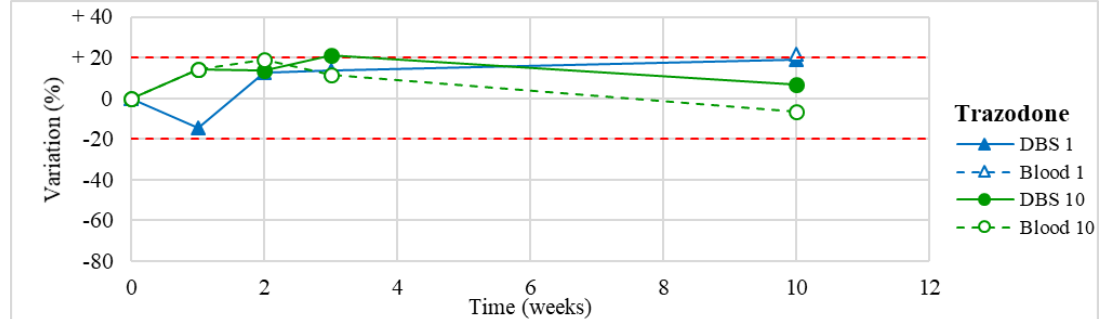
Figure 7. Long-term stability of desvenlafaxine ( n = 3) in DBSs stored at room temperature and in